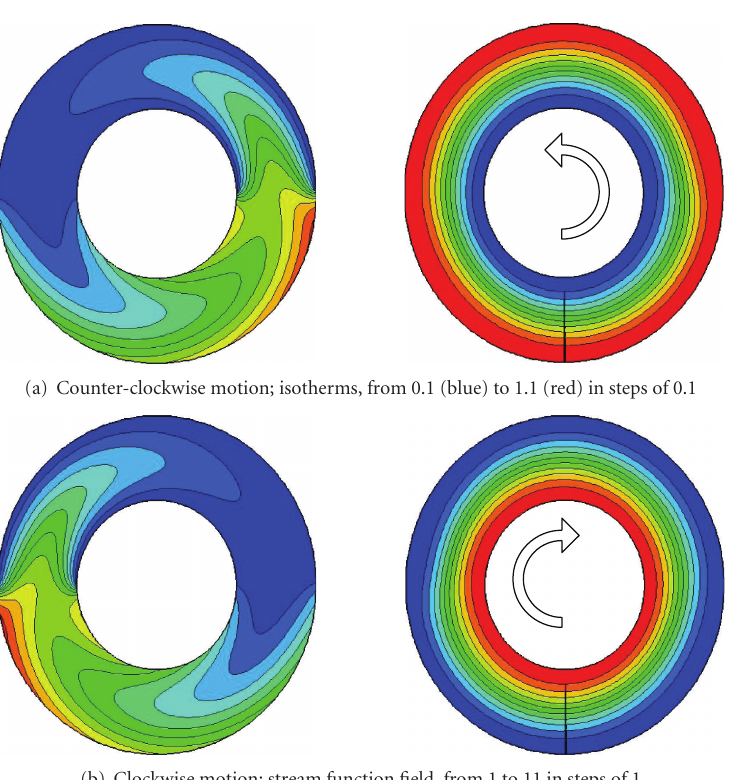
Figure 4: Temperature and stream function fields in a convective regime; Ra = 1000, R = 2 . 0, and Pr =